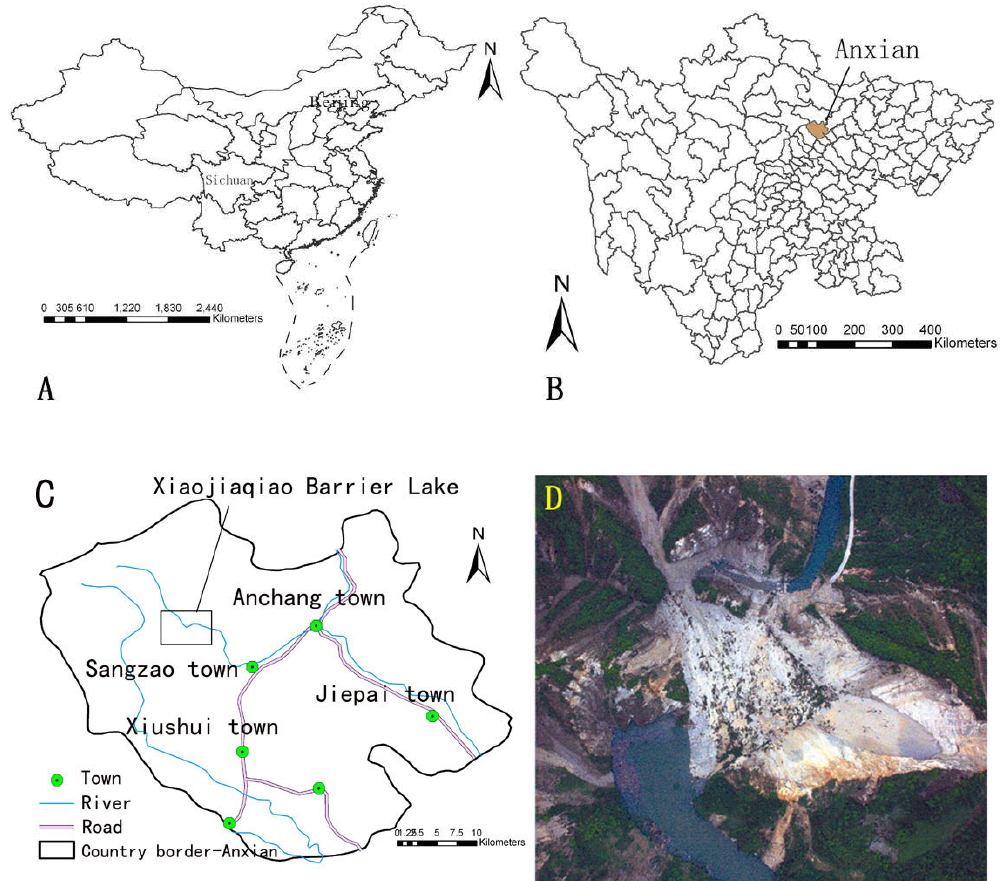
Fig. 1. Location of the study area: (a) Map of China, in which the annotated area is Sichuan province. (b) Map of Sichuan, in which the annotated area is Anxian. (c) Map of Anxian, in which the annotated area is the Xiaojiaqiao barrier lake. (d) A UAV photo of the Xiaojiaqiao barrier